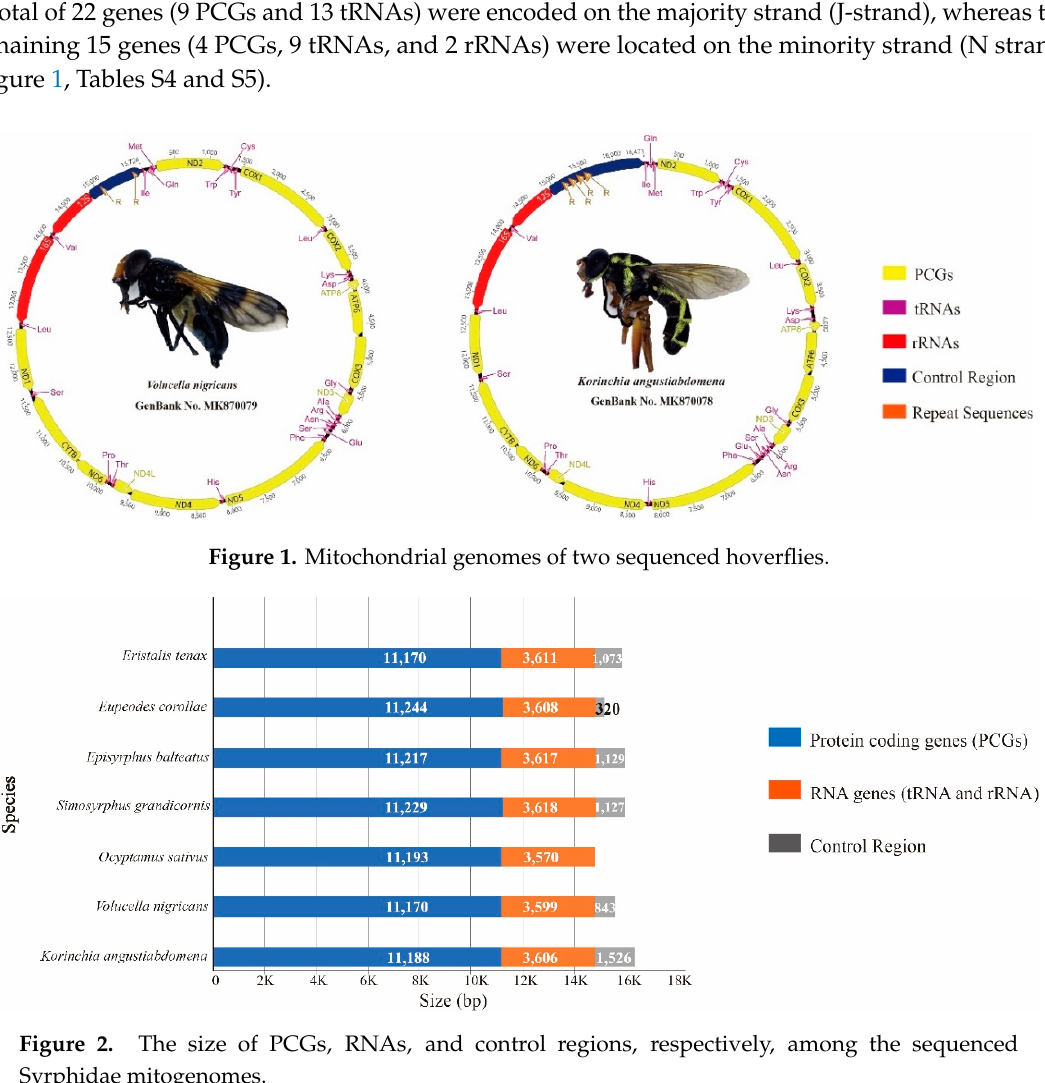
Figure 2. The size of PCGs, RNAs, and control regions, respectively, among the sequenced Syrphidae mitogenomes.